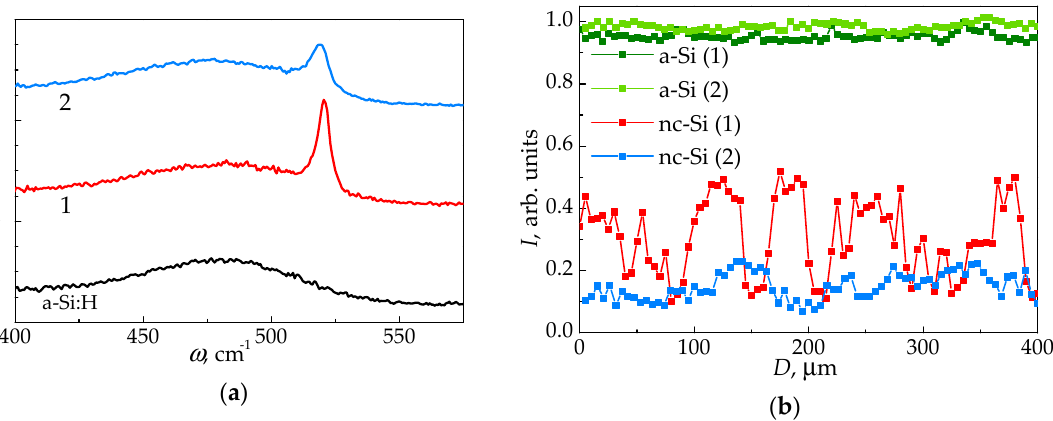
Figure 3. ( a ) Raman spectra for unirradiated amorphous silicon, as well as for samples 1 and 2 normalized by maximum intensity at ω A . For sample 1, the spectrum corresponds to the middle of the scan line. ( b ) Integrated TO phonon modes intensities corresponding to a-Si and nc-Si for the samples 1 and 2, mapped in the direction orthogonal to the scan lines, and normalized by the maximum integrated a-Si:H TO phonon mode